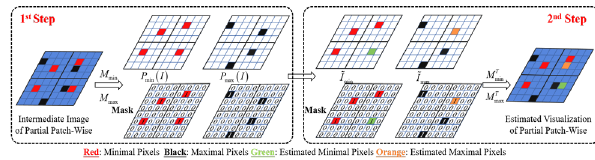
Figure 4. Flowchart of estimating I